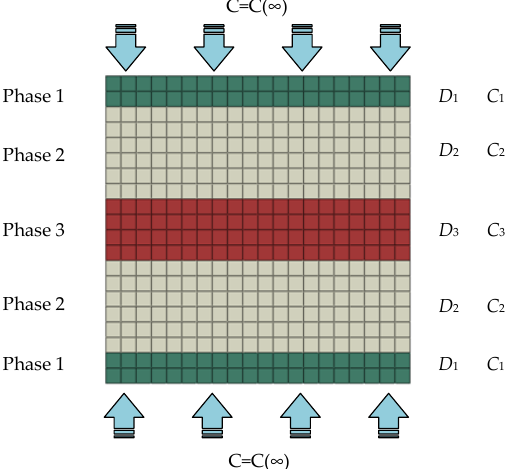
Figure 3. The FEA model for multiphase symmetrical sandwich structure.